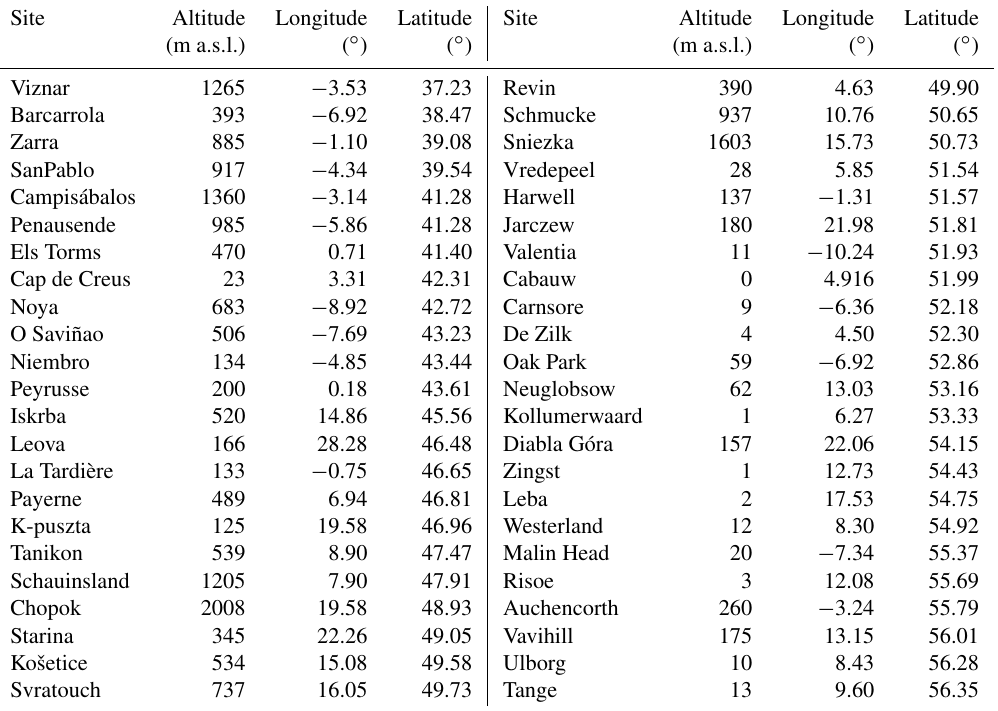
Table 1. Names and locations of the EMEP stations used for model comparisons to aerosol surface concentrations. The stations are ordered from south to north. The altitude above sea level (a.s.l.) is indicated because the surface measurements are compared to the first model vertical